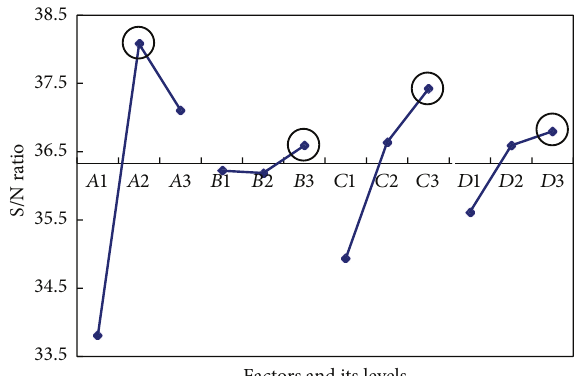
Figure3:Responsegraphofhigher-the-bettersignal-to-noiseratios